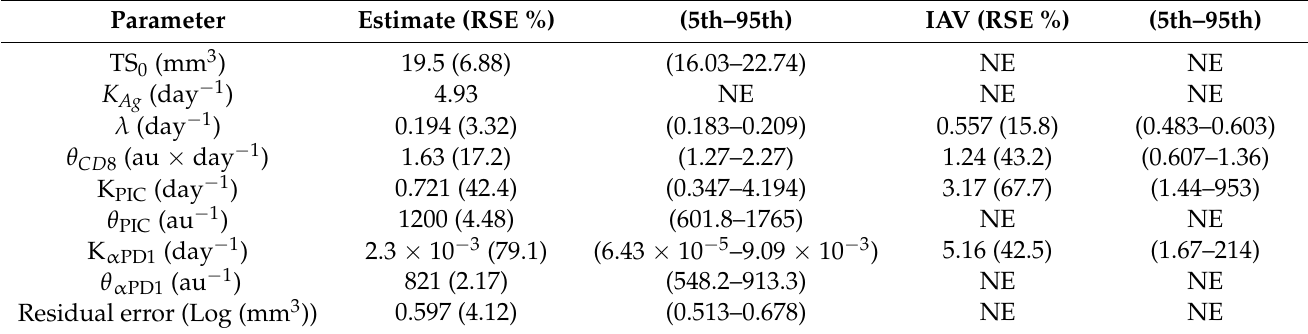
Table 3. Model parameter estimates.